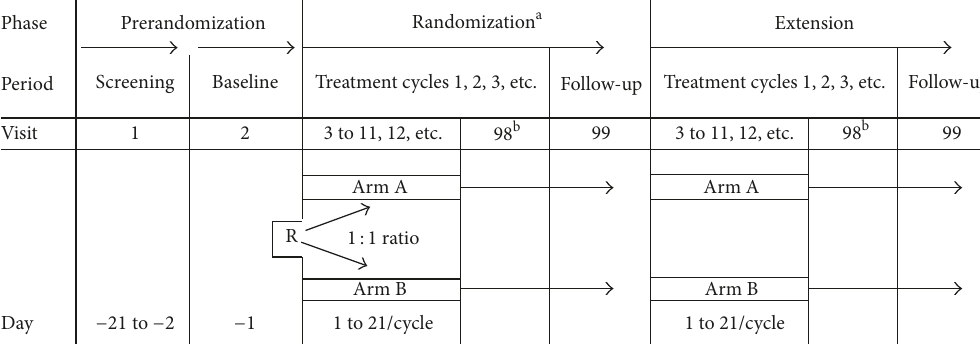
Figure 1: R: randomization. Arm A: eribulin mesylate 1.4 mg/m 2 IV on Days 1 and 8, every 21 days. Arm B: dacarbazine IV on Day 1, every 21 days. The starting dose must be selected from one of the following doses: 850 mg/m 2 , 1,000 mg/m 2 , or 1,200 mg/m 2 . a The randomization phase will end at the time of data cut-off for the primary analysis when the target number of events has been observed. All subjects still on treatment with study treatment or in survival follow-up will then enter the extension phase. b Off-treatment